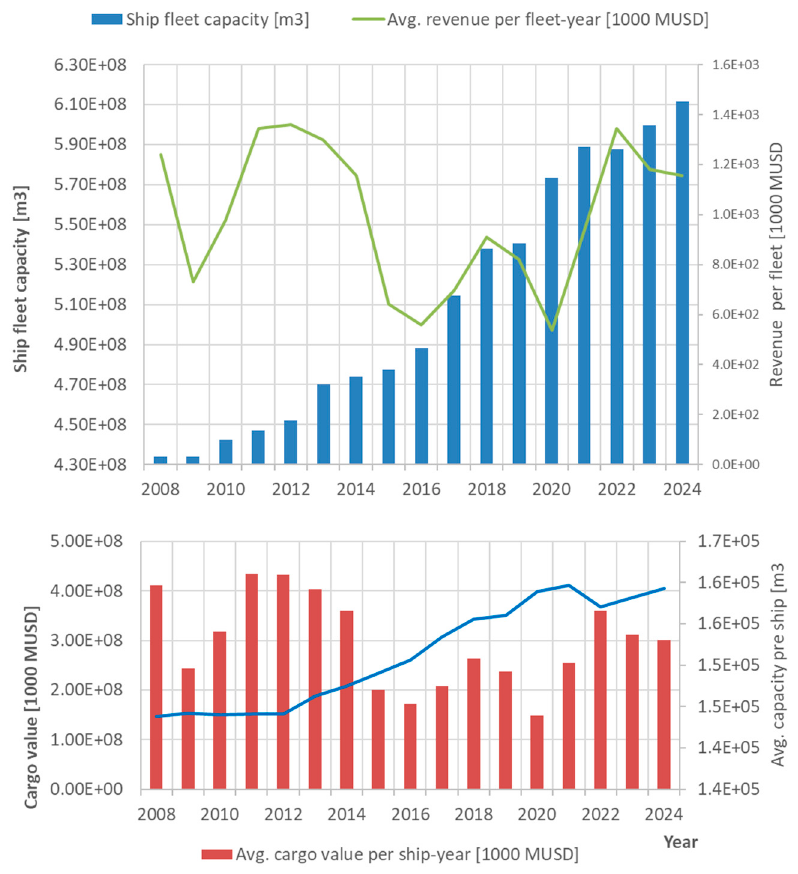
Figure 4. Oil tanker capacity and revenue.